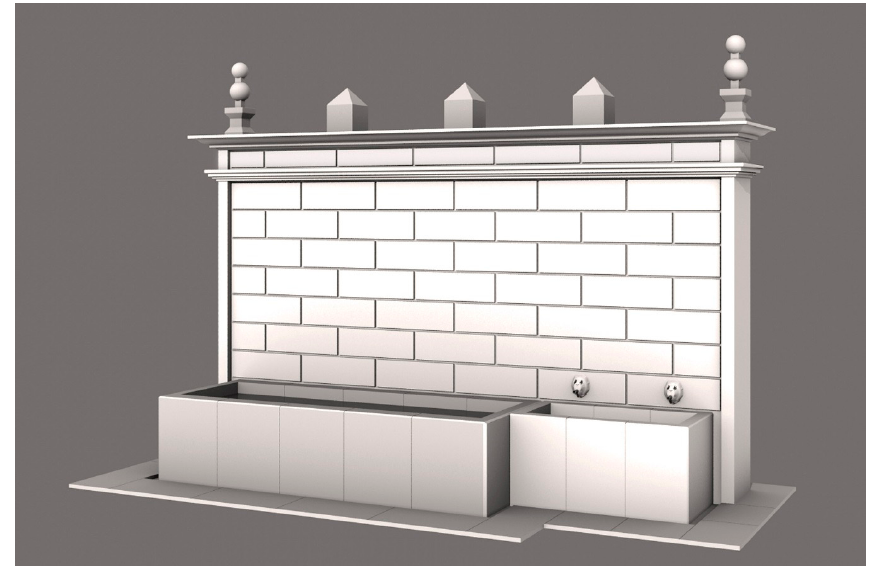
Figure 15. Perspective of the virtual reconstruction of the San Pedro fountain in Lugo. The image was provided by the authors.